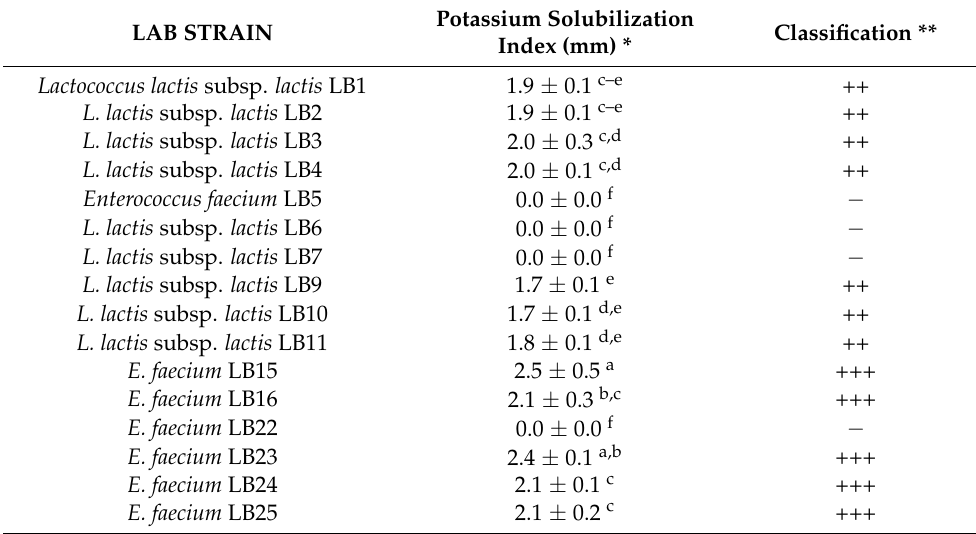
* Values are the mean ( ± SD) of three replicates. Values with no common letters ( a–f ) indicate significant differences at 5% probability level (LSD test). ** − , no halo zone; ++, 1.5 mm ≤ halo zone ≤ 2 mm; +++, > 2 mm halo